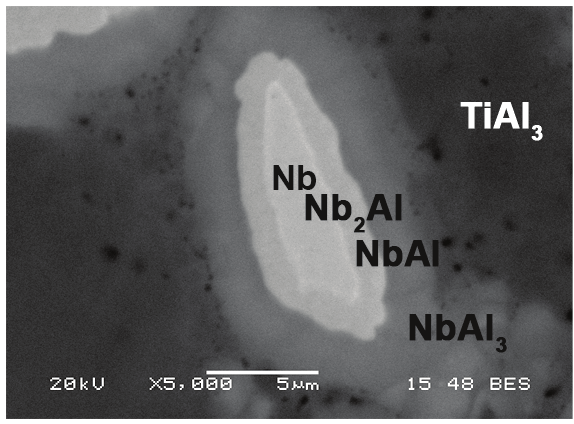
Figure 5: Peritectial reaction of Nb-Al